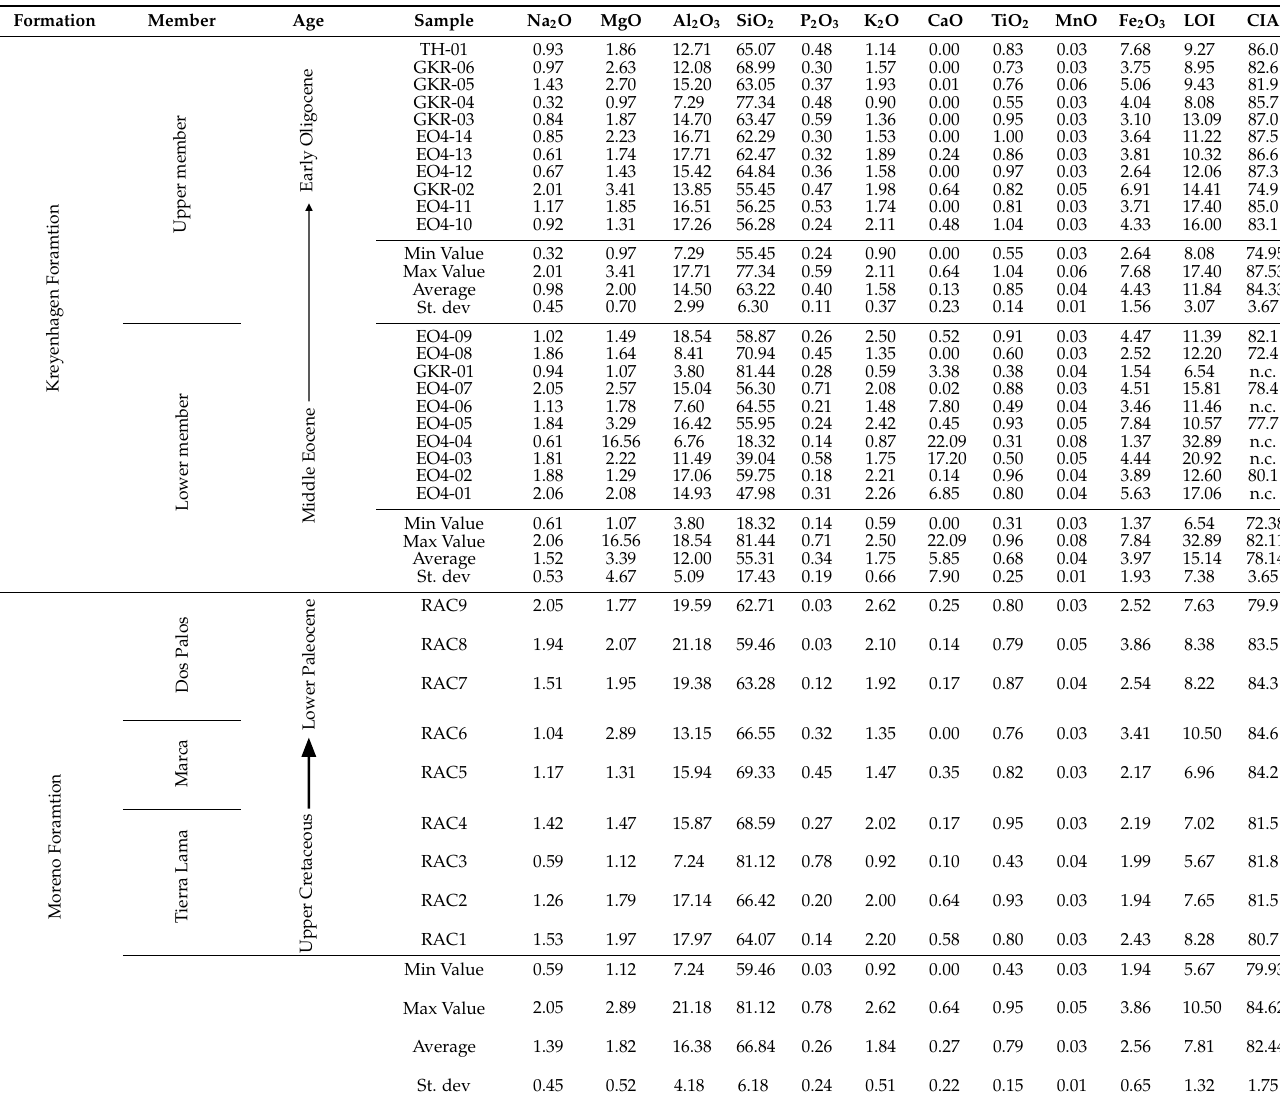
Table 2. Major element chemistry for samples shown in Table 1. LOI = loss on ignition. CIA = chemical index of alteration [25]. Formation Member